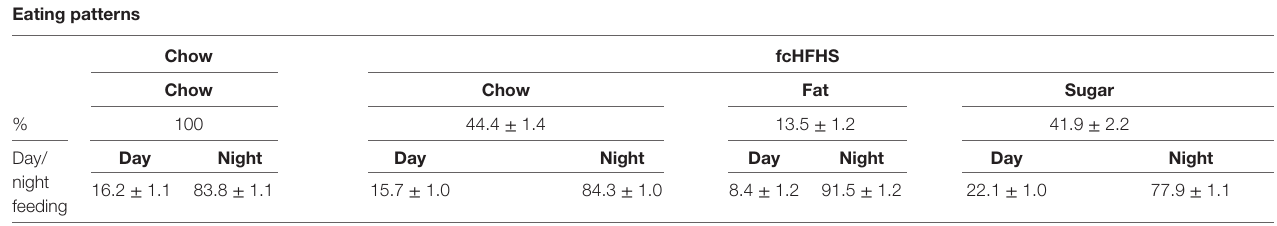
TaBle 1 | Eating patterns from chow-fed and free-choice high-fat high-sugar (fcHFHS) diet fed groups and mRNA expression from clock-genes Cry1 , Bmal1, Per2, and the Vglut2 gene. eating patterns chow